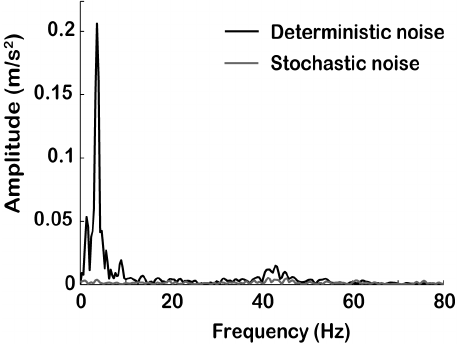
Figure 6. Amplitude-frequency spectrum of the deterministic and stochastic noise components. Amplitude-frequency spectrum of the deterministic and stochastic noise components of the acceleration profile whose total noise is illustrated in Fig. 3. The DSR of this profile is 13.48.